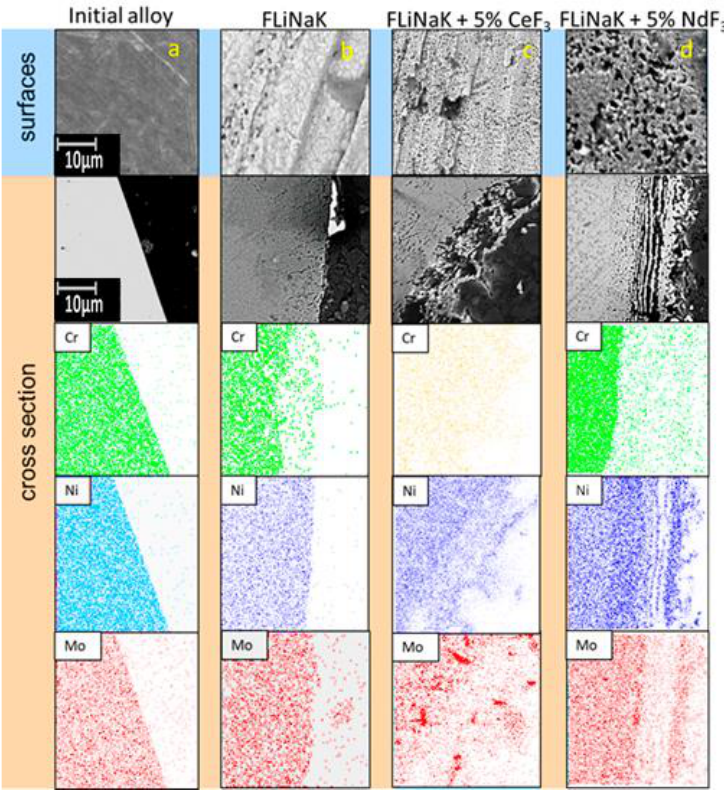
Figure 7. Structure of the surface layers of the samples of Hastelloy C2000 alloy after long-term corrosion tests: ( a ) initial; ( b ) exposed in FLiNaK; ( c ) exposed in the FLiNaK + 5 wt.% CeF 3 melt; ( d ) exposed in the FLiNaK + 5 wt.% NdF 3 melt.